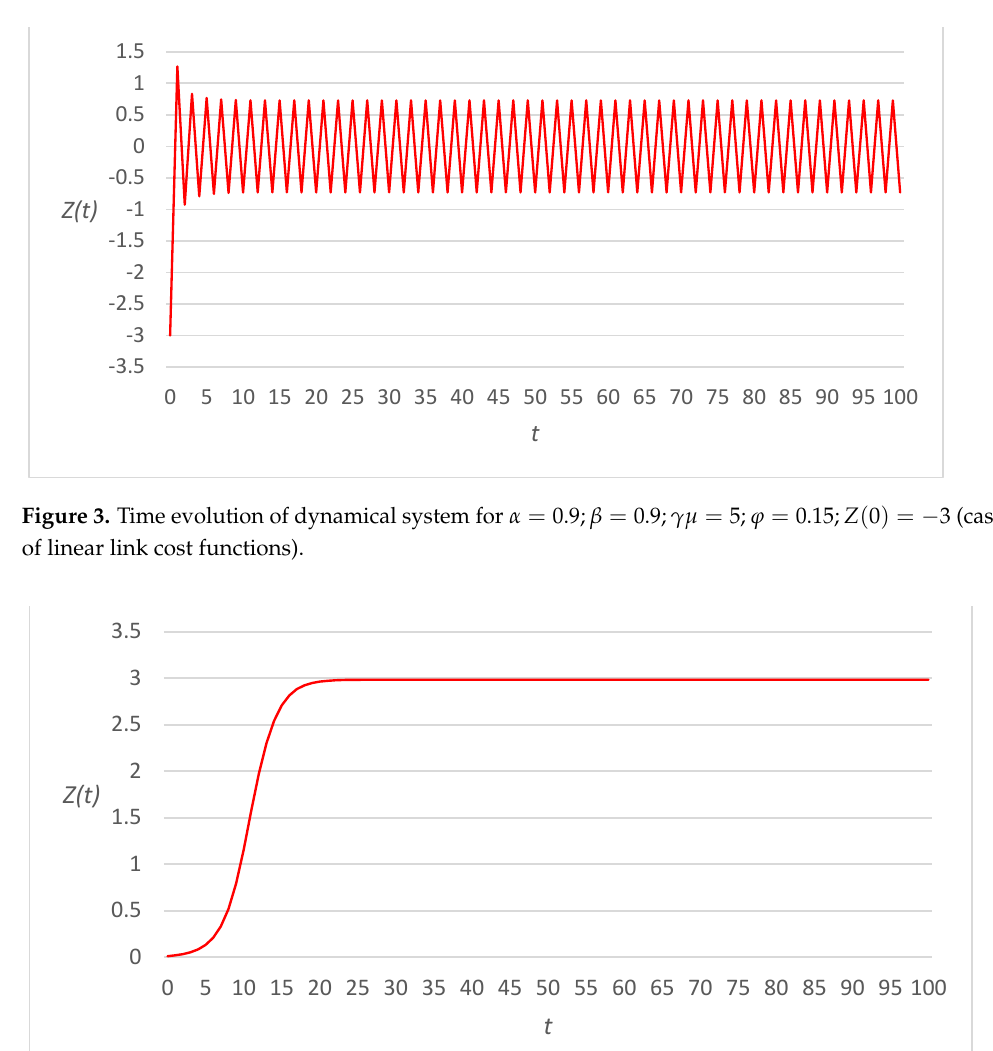
Figure 4. Time evolution of dynamical system for 𝛼 = 0.5; 𝛽 = 0.5; 𝛾𝜇 = 10; 𝜑 = 0.8; 𝑍(0) = 0.01 (case of linear link cost functions).